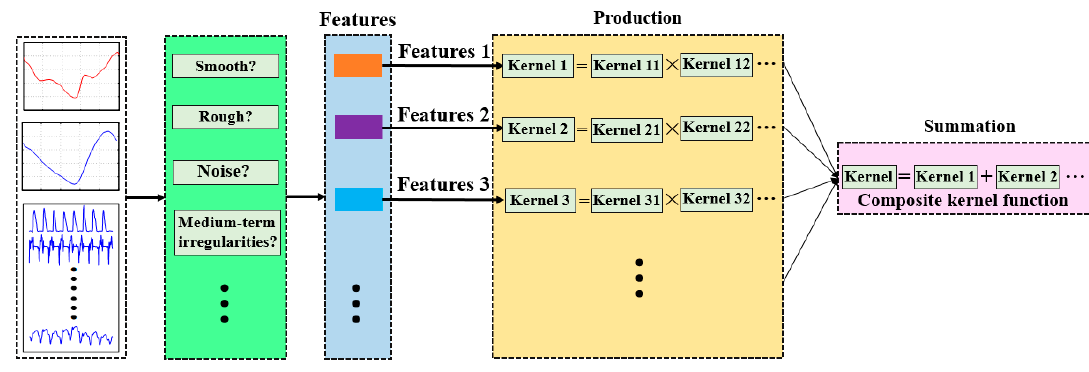
Figure 3. Framework of designed composite kernel function.